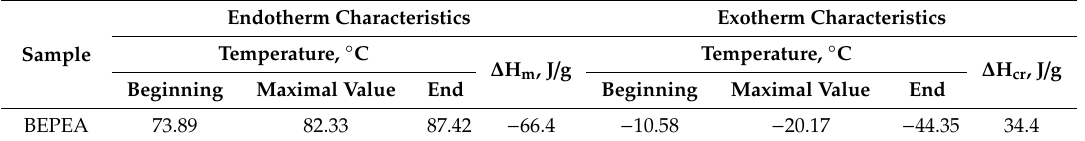
Table 4. DSC analysis of butoxyethylphenoxyethyl adipate plasticizer.